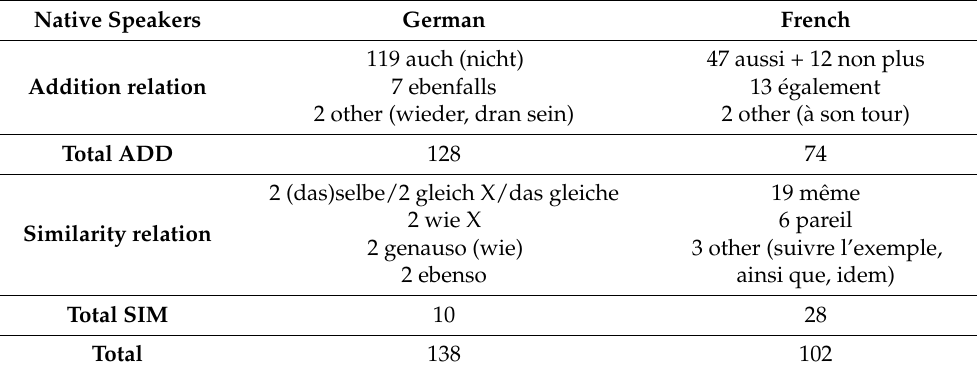
Table 4. Linguistic means used by native speakers in the additive